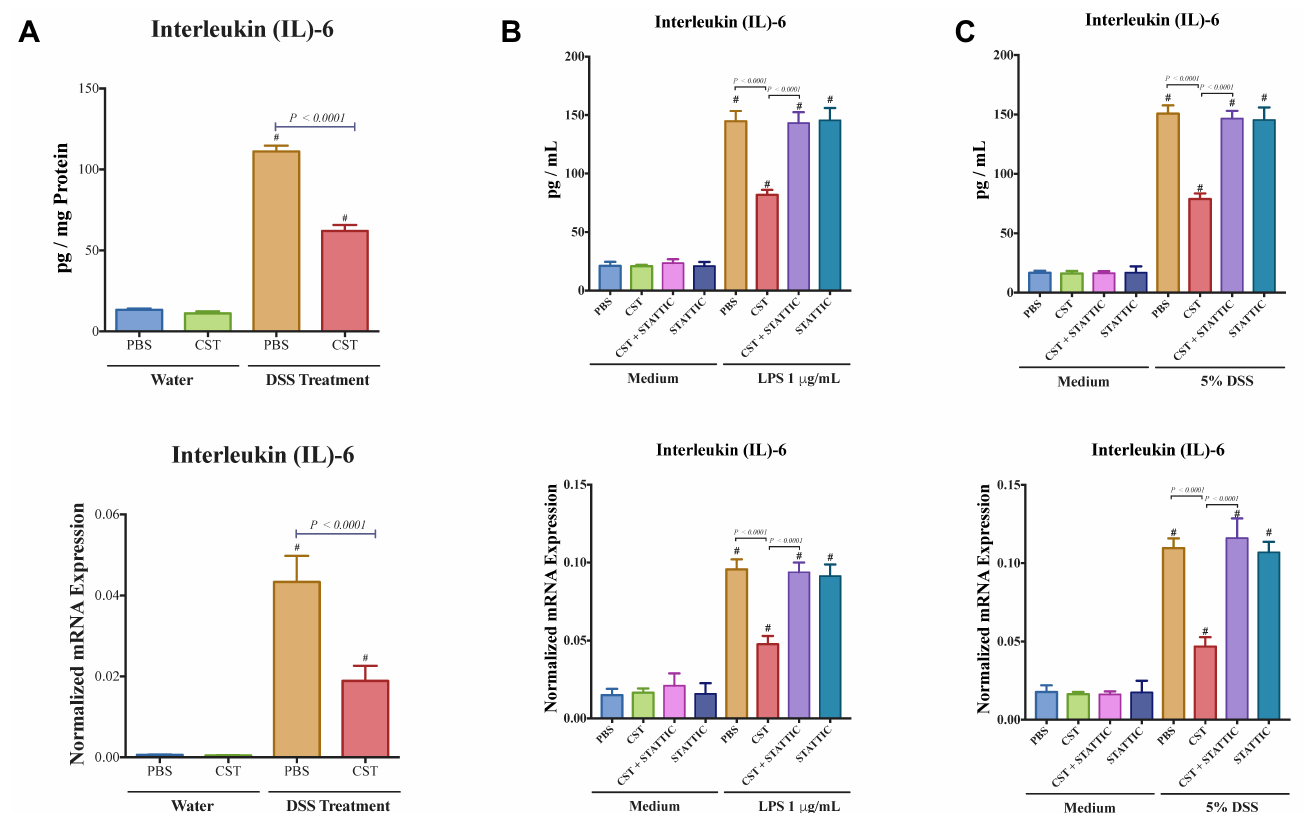
Figure 10. CST decreases IL-6 release in acute DSS-induced colitis and DSS- and LPS-stimulated Caco-2 epithelial cells. ( A ) Colonic protein and mRNA expression of interleukin (IL)-6 of C57BL6 mice were given 5% DSS solution in their drinking water to induce colitis. Control mice received water without dextran sulfate sodium (DSS). Preventive CST (1.5 mg/kg/day) peptides treatment or phosphate buffer saline (1 × PBS) started 1-day before colitis induction and lasted for 5-days. Caco-2 cells were treated with 1 × phosphate buffer saline (PBS) or CST (100 ng/mL) in medium for 24 h then challenged with LPS (1 µ g/mL) or 5% DSS for an additional 24 h in the presence or absence of STAT3 inhibitor (10 − 5 M, STATTIC; Sigma, Mississauga, ON, Canada); ( B , C ) The expression of IL-6 in DSS- & LPS-stimulated epithelial cells. One-way ANOVA was used to analyze the data followed by multiple comparison tests. Data represent mean ± SEM ( n = 6–8). # Compared to control